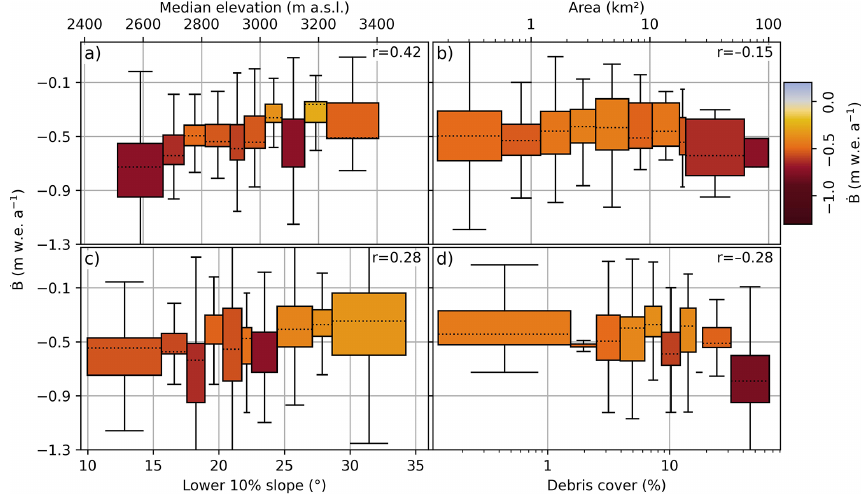
Figure 9. Area-weighted 10th percentile (0%–10%, 10%–20%, etc.) boxplots showing the relations between 1931–2016 average glacier mass change rates (vertical axes and colours) and different morphological parameters (horizontal axes). The whiskers extend from the box by 1 . 5 × the inter-quartile range (IQR). The stated Pearson correlation coefficients ( r ) refer to the unbinned variables. (a) Correlation with median glacier elevation, indicating that lower elevations show larger mass loss rates. (b) Correlation with glacier area, showing no clear relation. (c) Correlation with the slope of the lowermost 10% of the glacier surface, possibly showing higher mass change rates for glaciers with flatter termini. (d) Correlation with fractional debris cover in 2016 (taken from Linsbauer et al., 2021), indicating that higher mass change rates may be found for glaciers with high debris-coverage